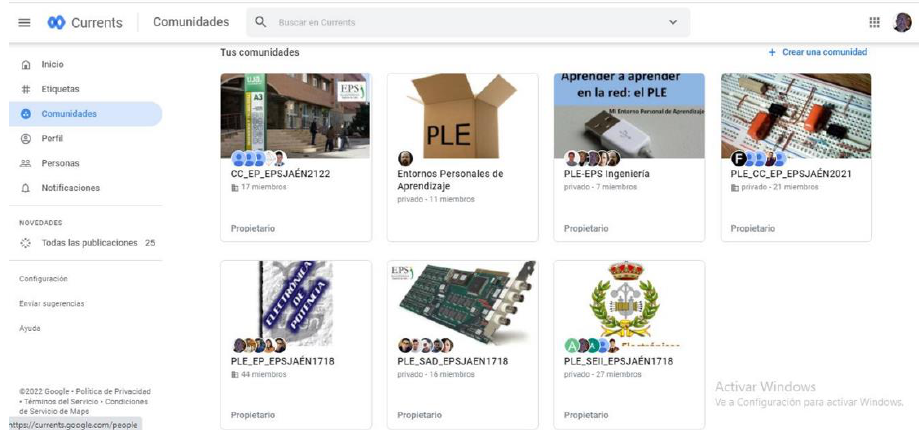
Figure 7. Example of the groups’ results dissemination.